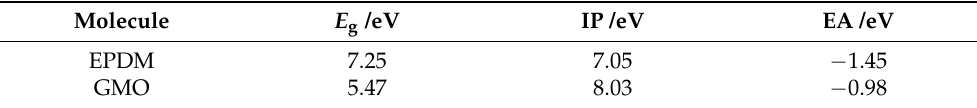
Table 6. Electronic properties of EPDM polymer and GMO molecule.